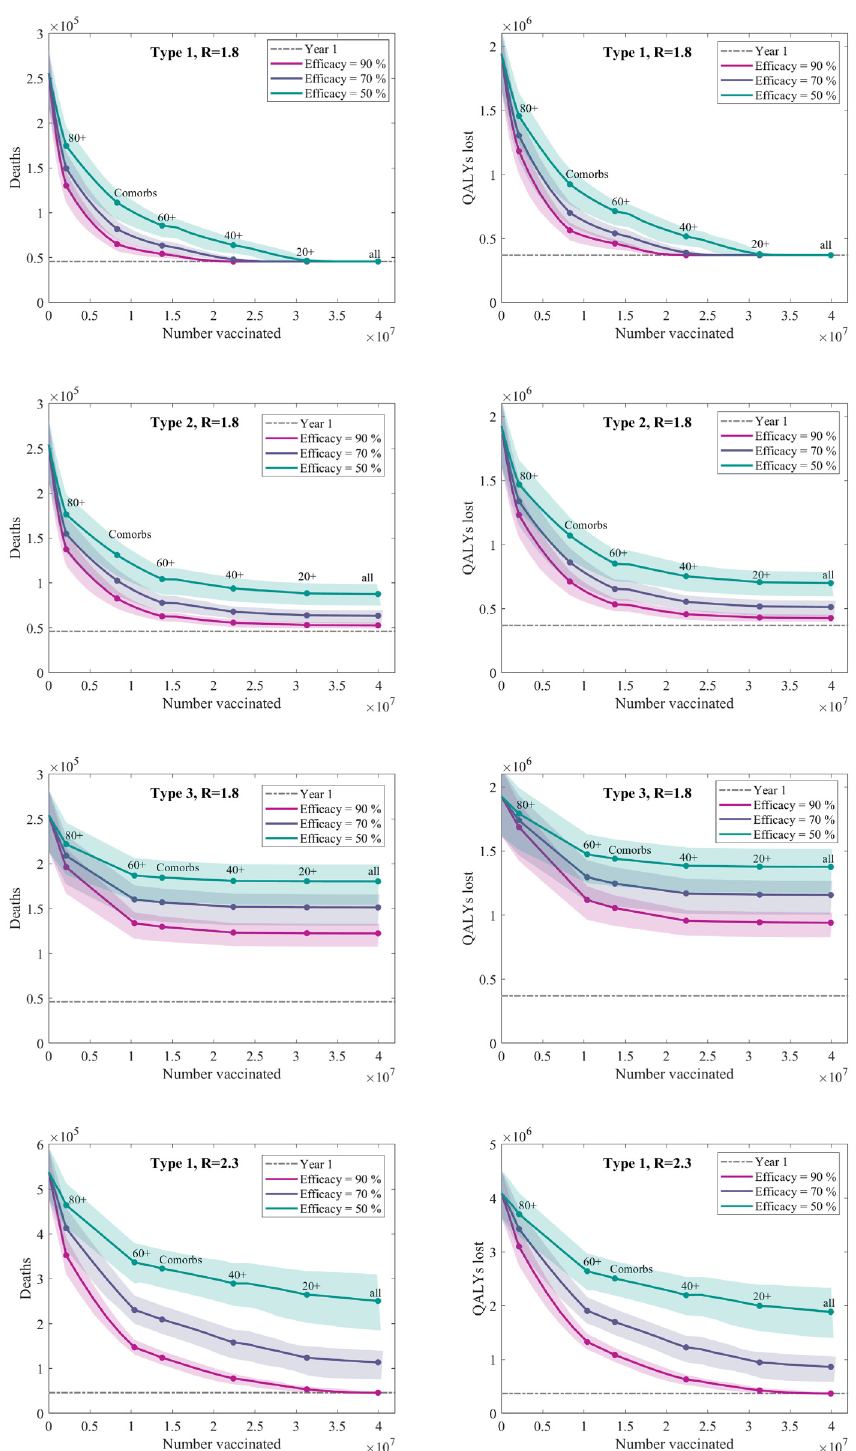
Fig 7. Deaths and QALYs lost versus the proportion of the population vaccinated. We use the optimal vaccination ordering with a maximum vaccine uptake of 70% across the population. The optimal vaccination ordering did not depend on the collection of considered vaccine efficacies. We display the mean values of 100 independent simulations for each vaccine efficacy (solid lines), with 95% prediction intervals (shaded regions). The grey dotted line shows the base level of mortality from the first wave of the